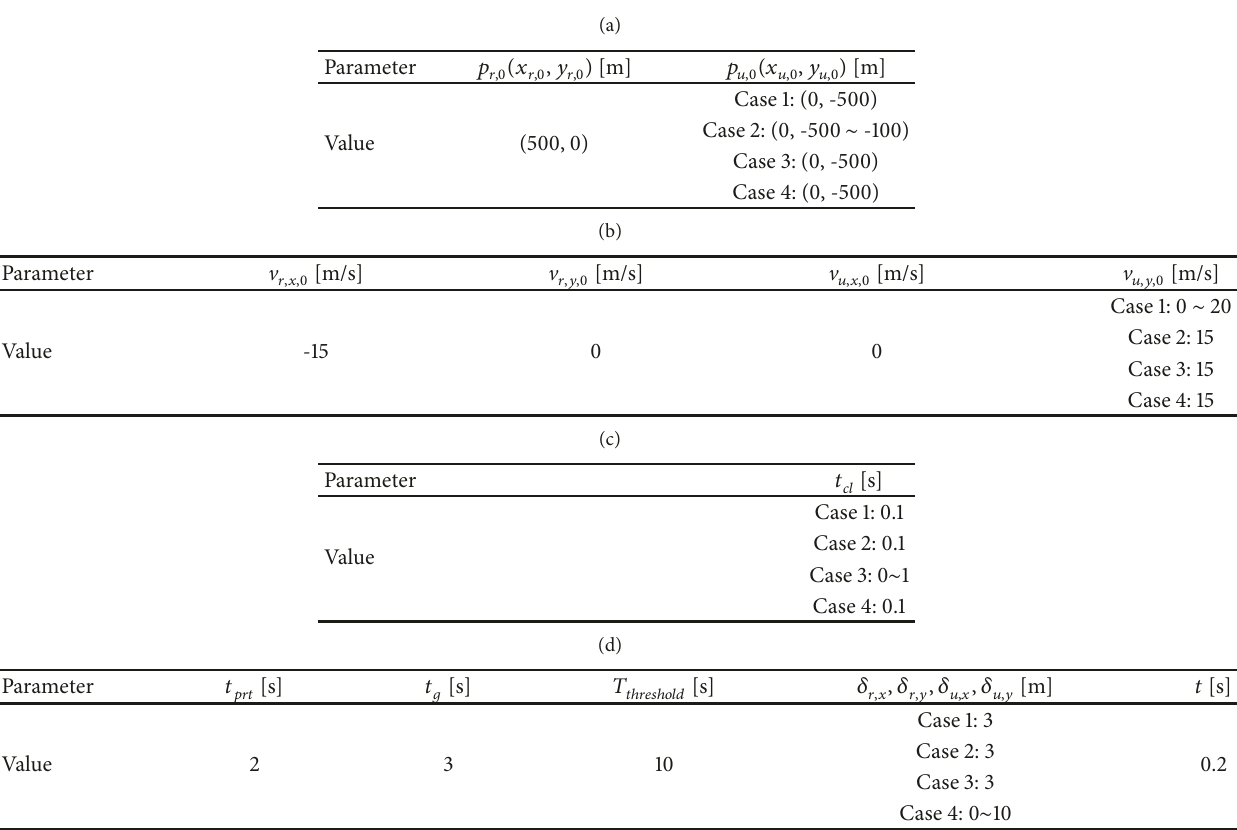
Figure 5: Crossing risk probability for different initial locations. (a) No-control scenario. (b) Control scenario. Table 1: Model parameter values in simulation. (a) Location parameters. (b) Speed parameters. (c) Communication latency parameter. (d) Other